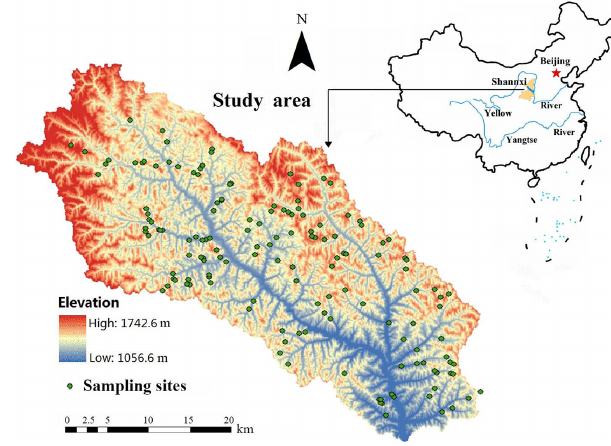
Figure 1. Location of the study area and sampling